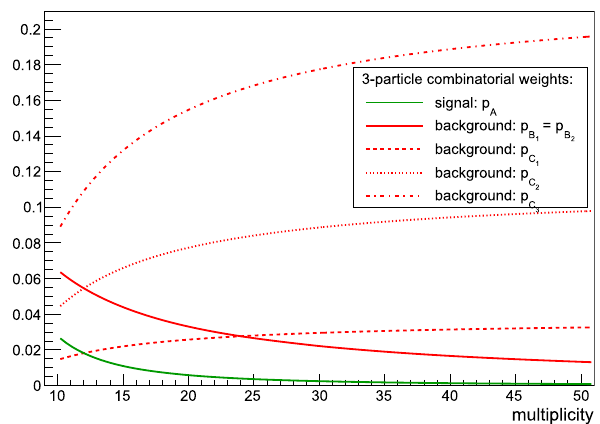
Fig. 4 Multiplicitydependence of six combinatorial weights for three- particle correlations: p A , p B , p B , p C , p C and p C (see the main text 1 2 1 2 3 for their definitions and further explanation). The contribution from genuine three-particle correlations (signal) is weighted with p A (green line),andalreadyfor M ≈ 50 thiscontributionbecomesnegligible.The contribution from genuine two-particle correlations is also suppressed for large multiplicities (solid red line). The remaining weights, p C , 1 p C and p C , all correspond to independent particle emission, and their 2 3 relative contribution increases as multiplicity increases